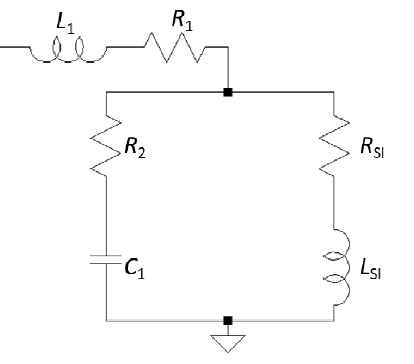
Figure 6. Equivalent circuit of the device under test. R 1 , R 2 , L 1 , and C 1 are parasitic elements; R SI and L SI are the transducer elements of the diaphragm.